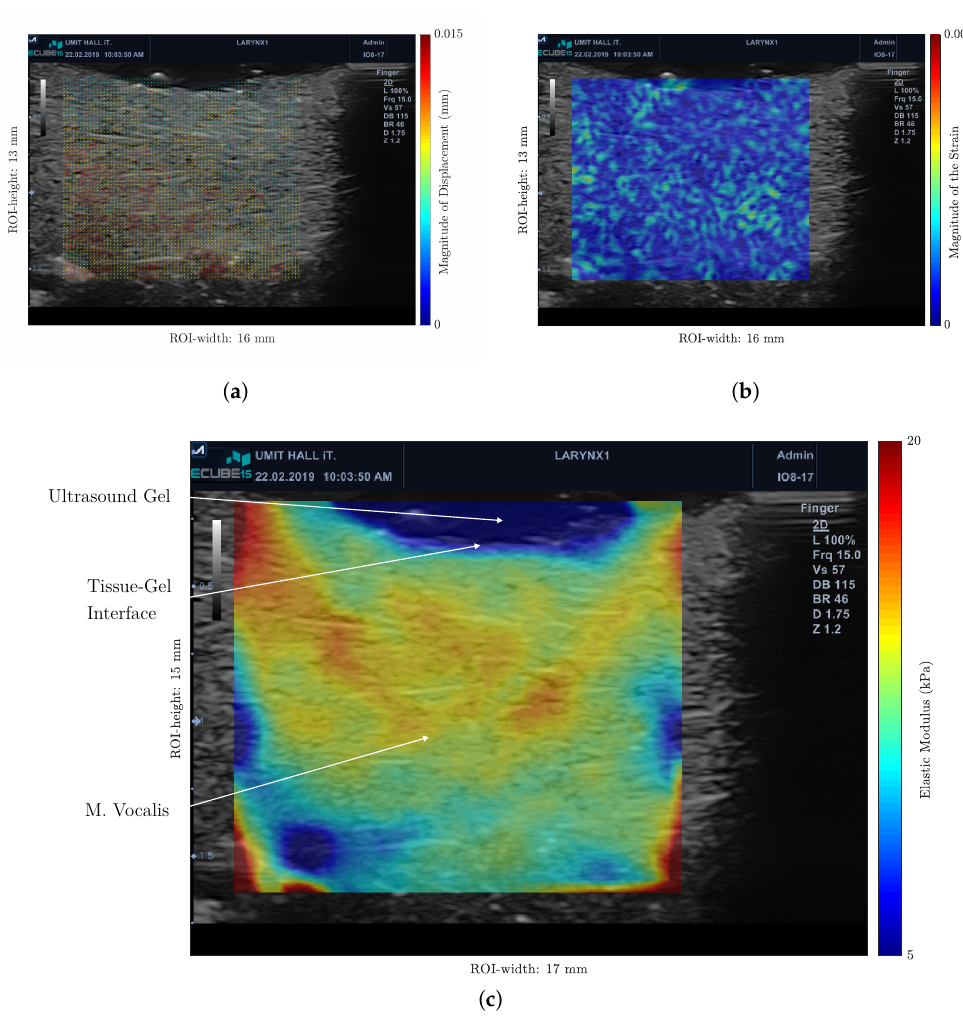
Figure 6. Measurements of the VFs. The VFs were fixed in the measurement setup and examined with the Alpinion IO8-17 transducer placed on the shown position (Figure 1a). The resulting images were evaluated with the presented algorithm: starting with the estimation of the displacement field ( a ), calculating the strain ( b ), and finally, the elastic modulus ( c ). ( a ) Displacement field in the tissue. ( b ) Strain in the tissue. ( c ) The elastic modulus of the